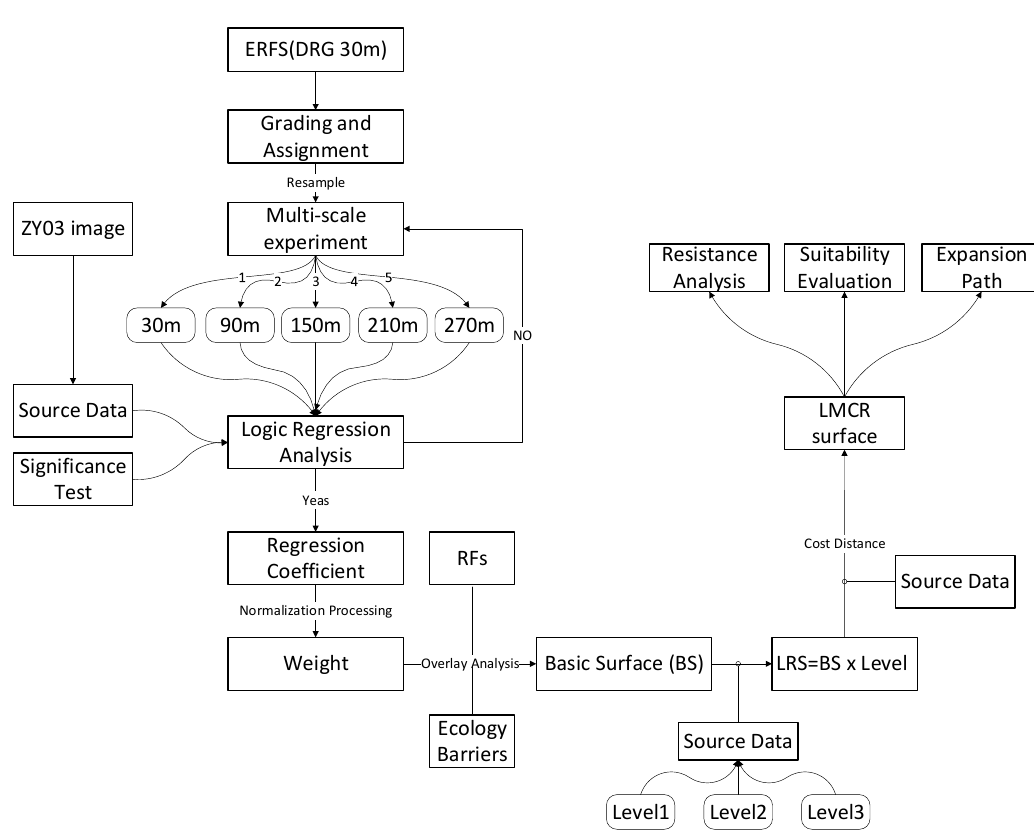
Figure 6. Flow chart of the improved Minimum Cumulative Resistance ( Logic minimum cumulative resistance) model . resistance)